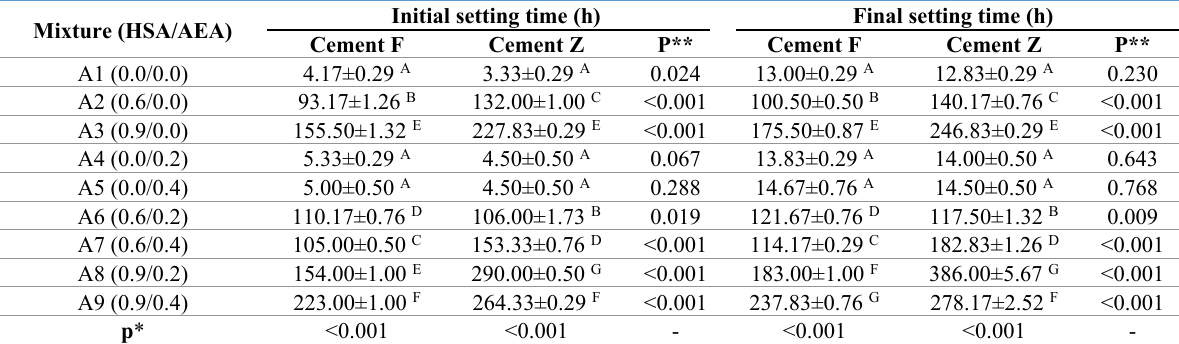
Table 6. Mortar setting time (M±SD) using cements F and Z, by the tangent method. Initial setting time Mixture (HSA/AEA)